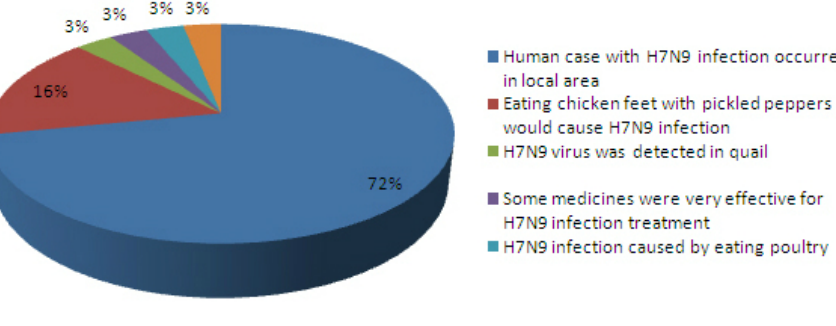
Figure 8. A total of 32 confirmed rumors for H7N9 outbreaks classified by main content during the H7N9 outbreaks in China from March 31 to April 24,